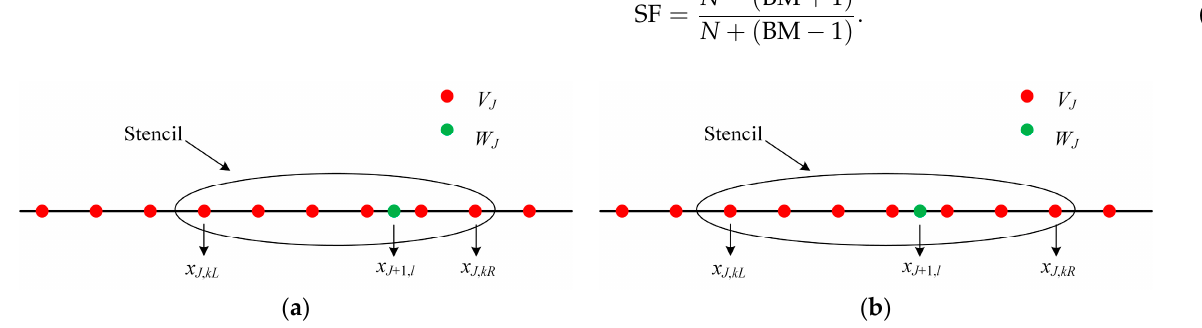
Figure 1. Examples of stencils: ( a ) Stencil for the asymmetrical wavelet with N = 6 and BM = 2; ( b ) Stencil for the asymmetrical wavelet with N = 7 and BM = 1. Table 1. BM and SF for the scaling functions. It can be observed from Equation (18) that the SF approaches to 1 as N tends to infinity,